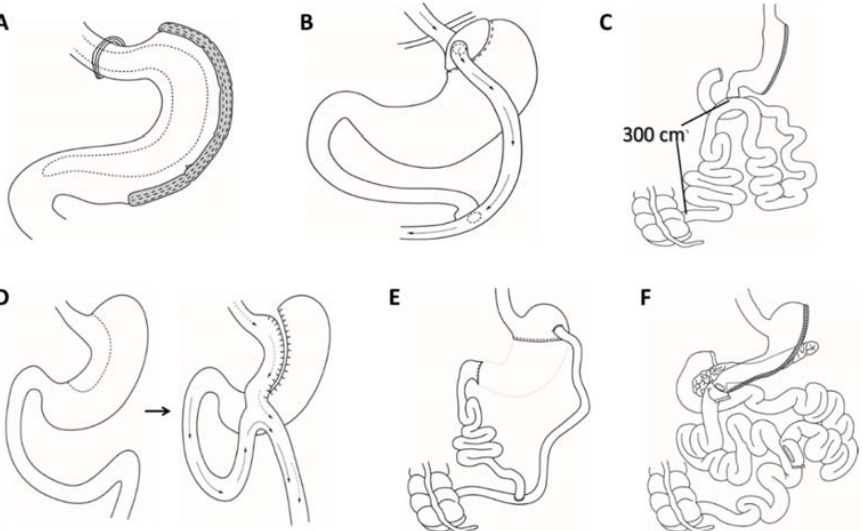
Figure 3. The most common bariatric surgery procedures. ( A ) Vertical sleeve gastrectomy (VSG); ( B ) Roux ‐ en ‐ Y gastric bypass (RYGB); ( C ) Single anastomosis duodeno–ileal bypass with sleeve gastrectomy (SADI ‐ S); ( D ) Mini gastric bypass (MGB); ( E ) Biliopancreatic diversion (BPD); and ( F ) Biliopancreatic diversion with duodenal switch (BPD/DS).